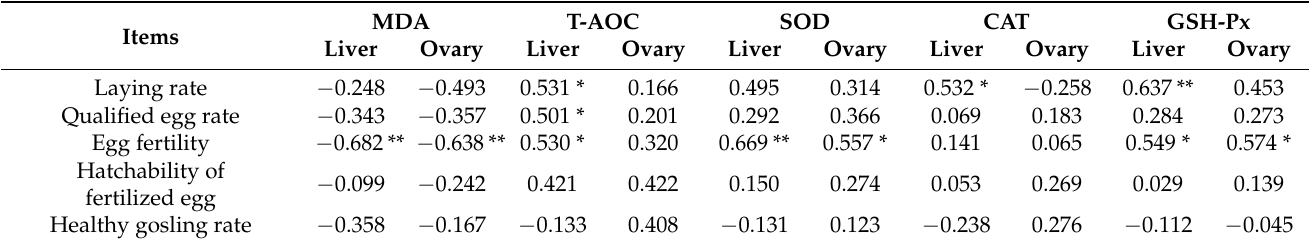
Table 9. Correlation analysis of reproductive performance index and antioxidant capacity index in liver and ovary 1 .